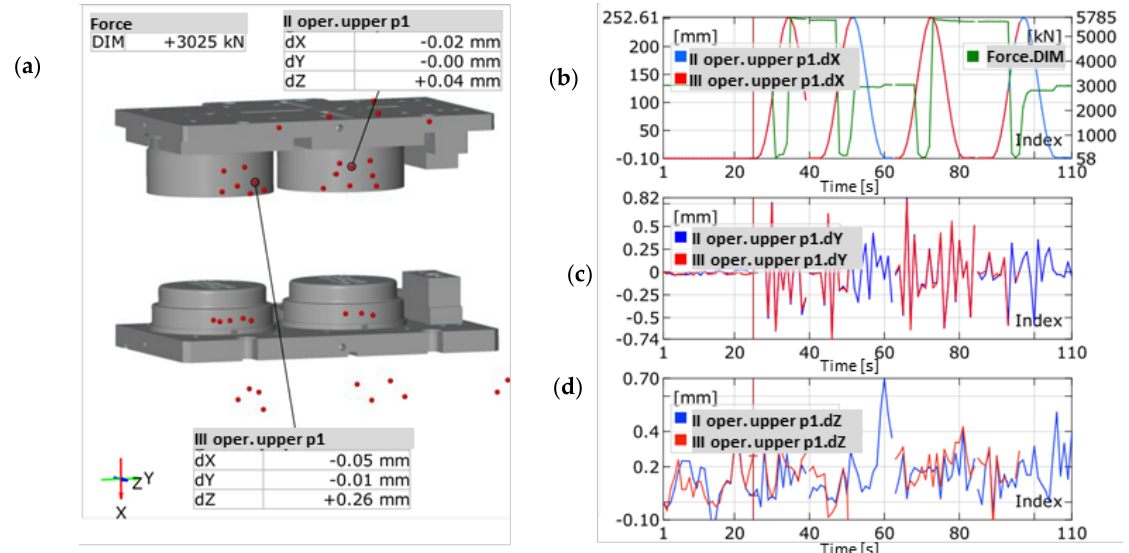
Figure 7. Example of the use of dynamic systems for the measurements of the forces and displacements in a forging operation: ( a ) measurement result for an open press, ( b ) change in the position value in axis X of selected reference points, ( c ) change in the position value in axis Y of selected reference points, ( d ) change in the position value in axis Z of selected reference points.